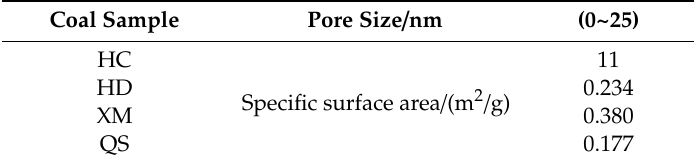
Table 8. Specific surface area of coal samples.